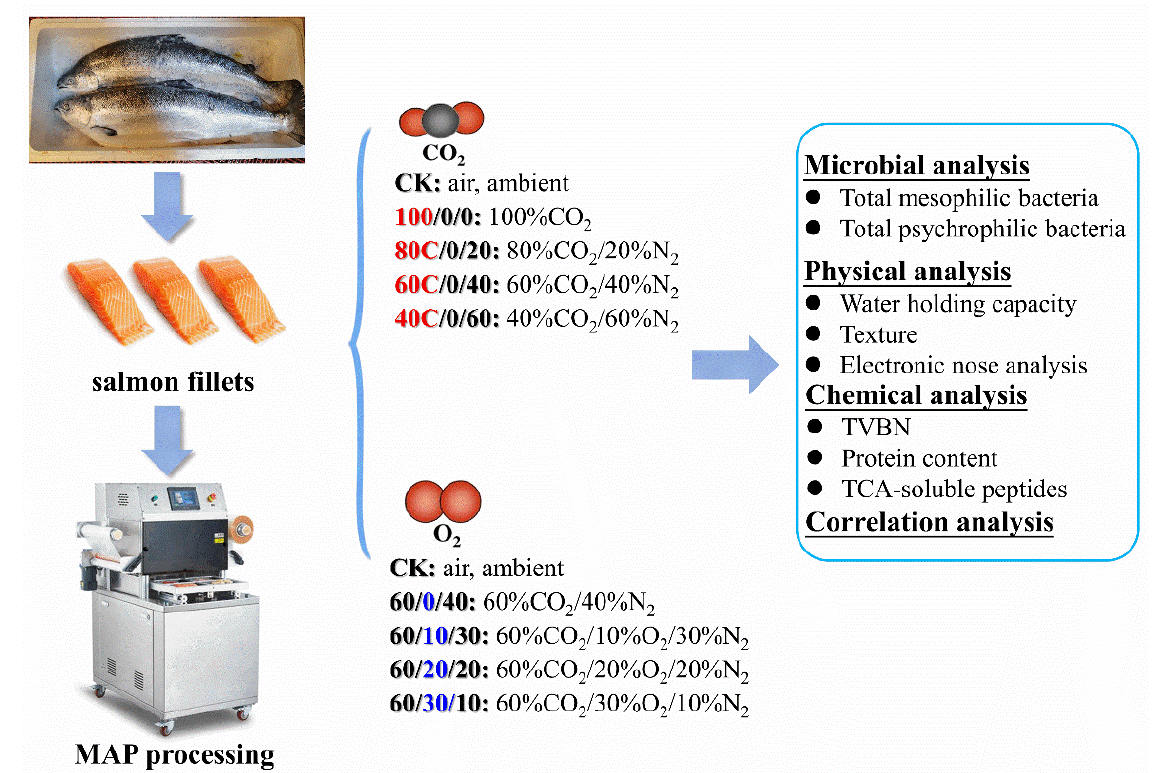
Figure 1. A schematic overview of the experimental study.